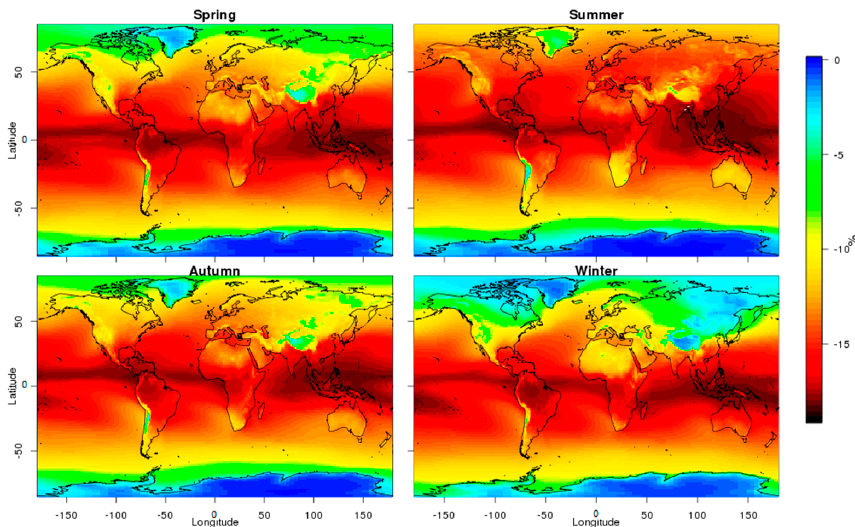
Figure 7. Global spatial distribution of seasonally averaged PWV effect during the period 2000–2019. PWV effect is quantified by Equation (3) and refers to the effects on downwelling SW irradiance reaching the Earth’s surface under different values of PWV.